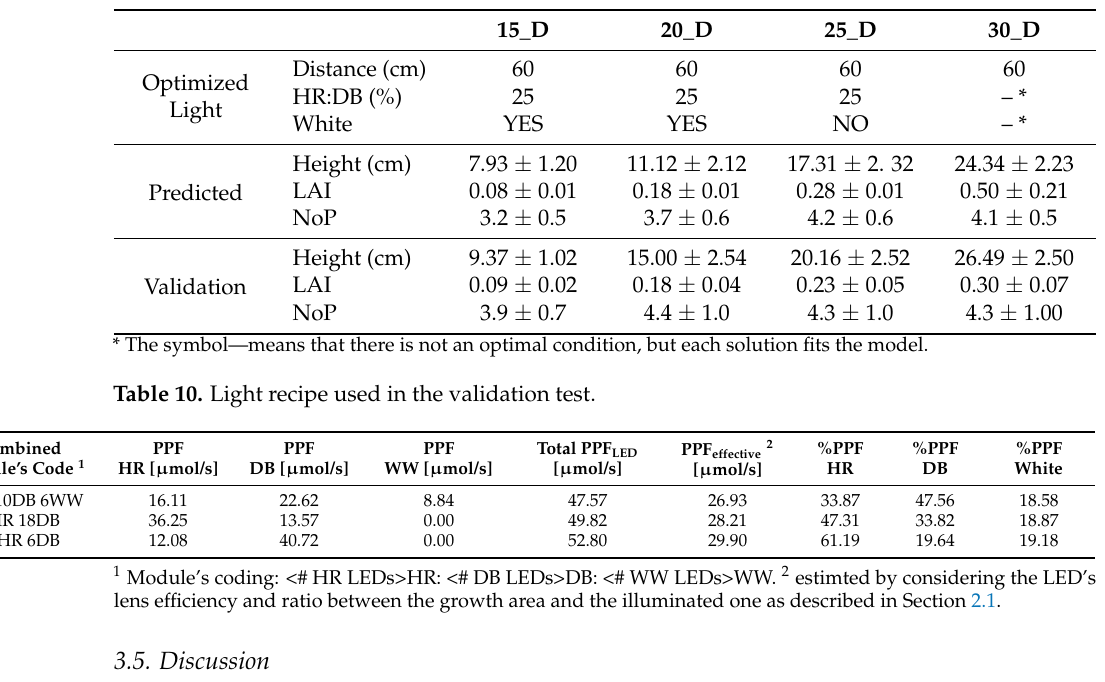
Table 9. Summary of the best solutions found by the desirability function and its experimental validation. Data regarding water are not present due too high % errors on the predicted values.